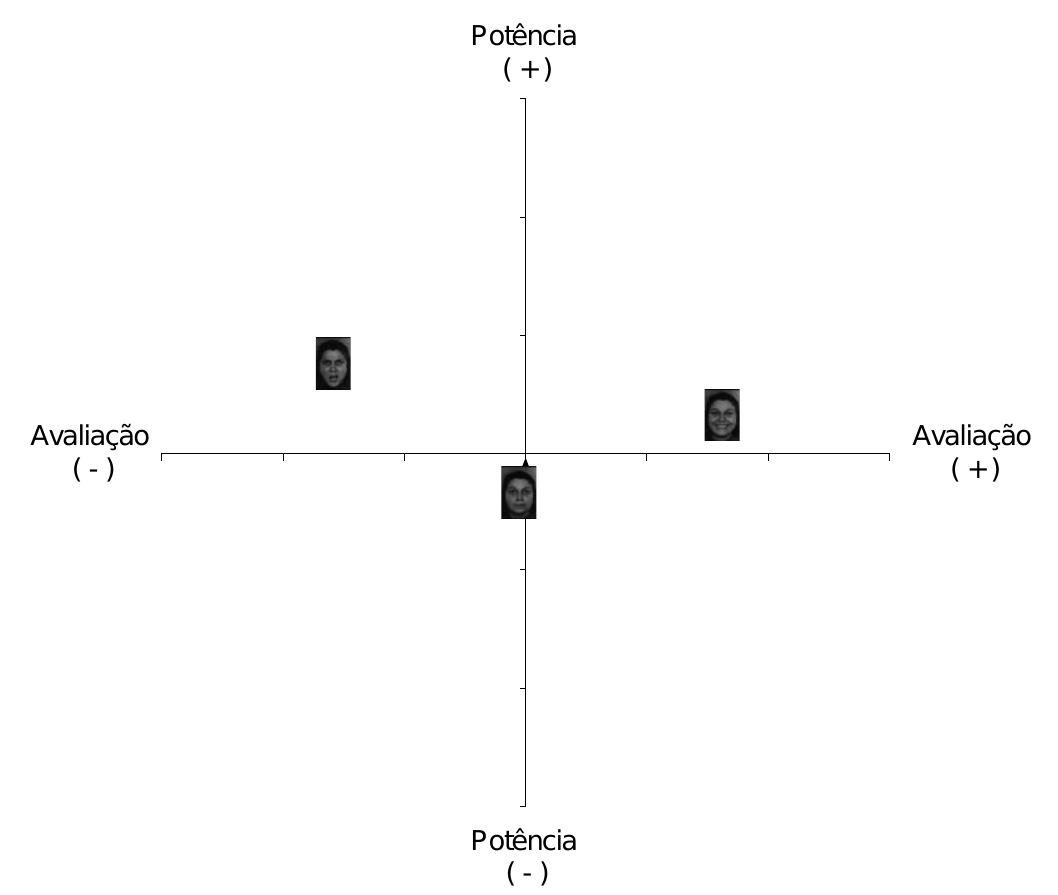
Figura 4 . Distribuição do signifi cado de três expressões faciais pelo espaço semântico criado a partir dos dois fatores extraídos do